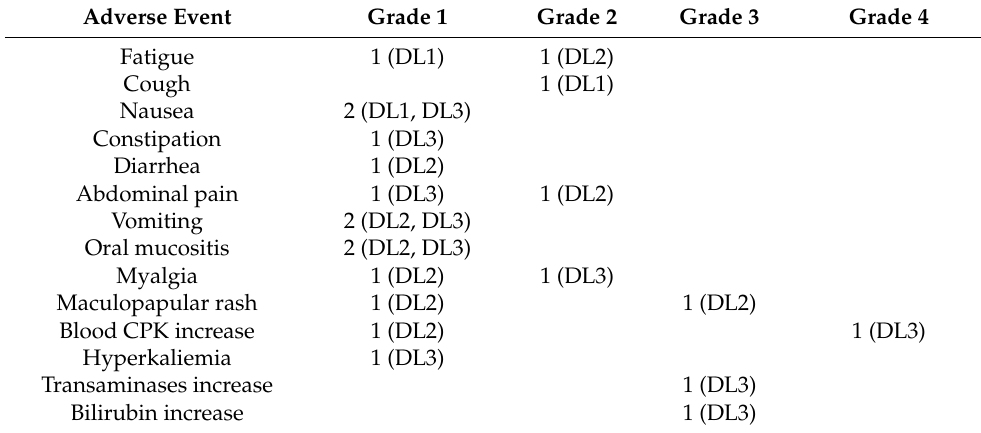
(DL) at which they